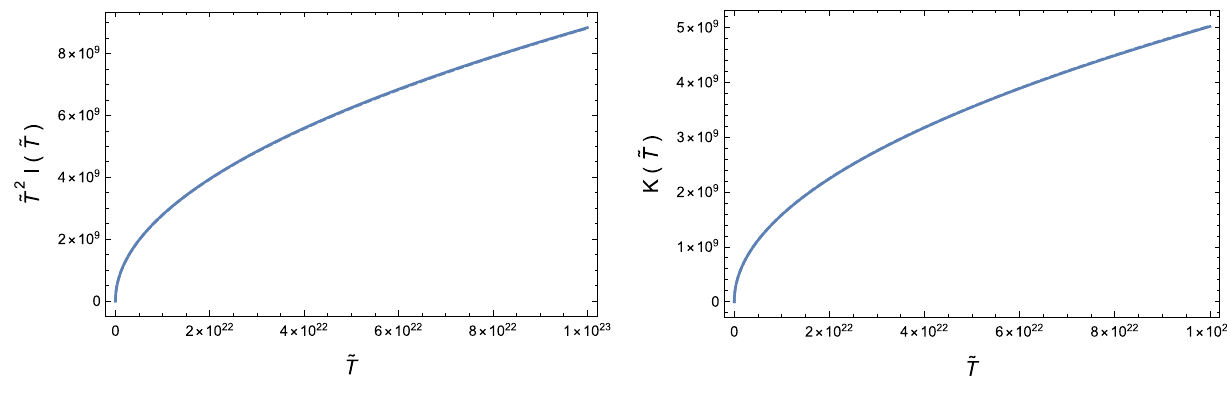
(cid:2) ˜ T (dotted curve) (left figure) and of the functions K